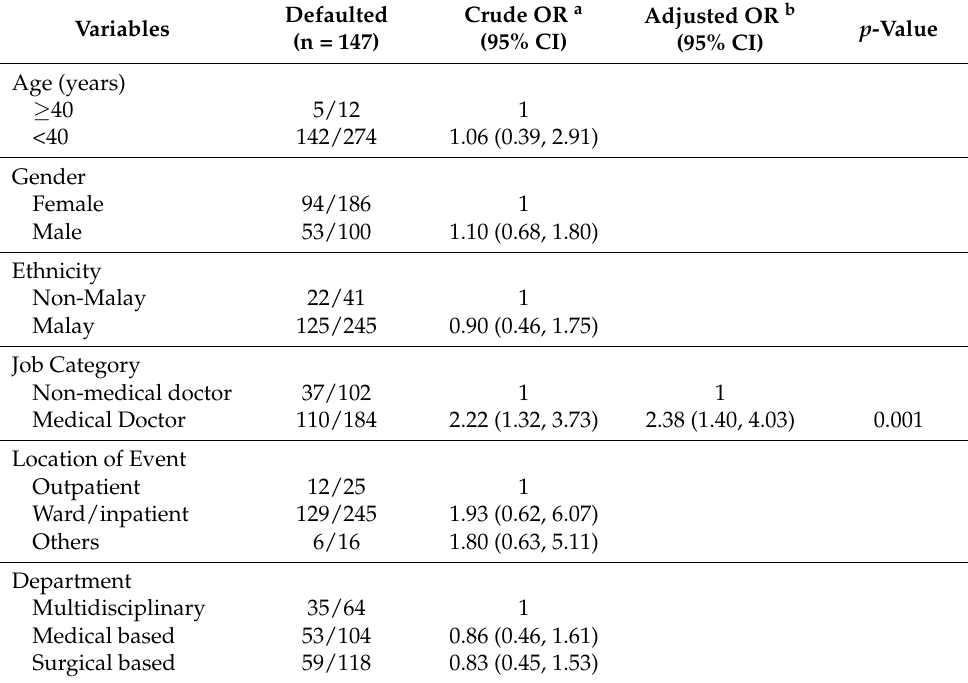
Table 2. Variables associated with defaulting the sharp injury follow-up among HCWs using simple and multiple logistic regression analyses (n = 286).